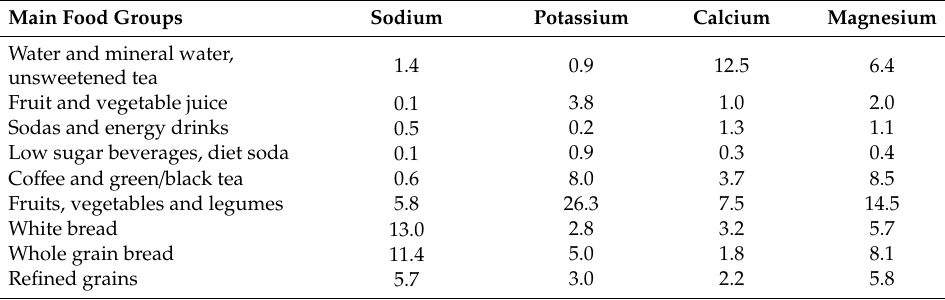
Table 4. Main food groups contributing to electrolyte intake (shown in